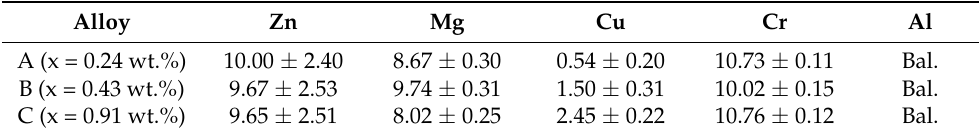
Table 3. Chemical composition of secondary phase in Al-5Zn-2.6Mg-xCu alloy (wt.%). Alloy Zn Mg